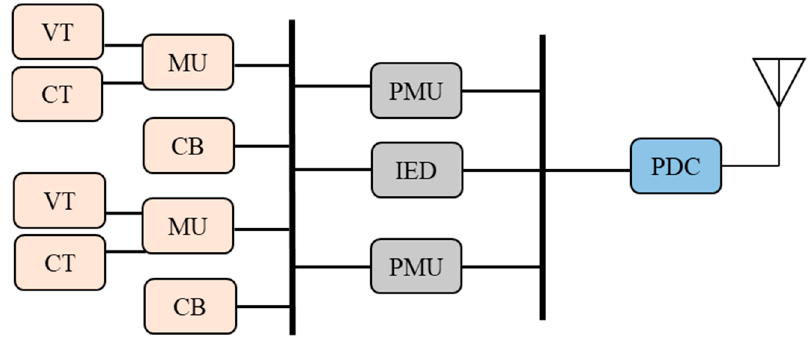
Figure 4. PDC and PMUs within a substation.